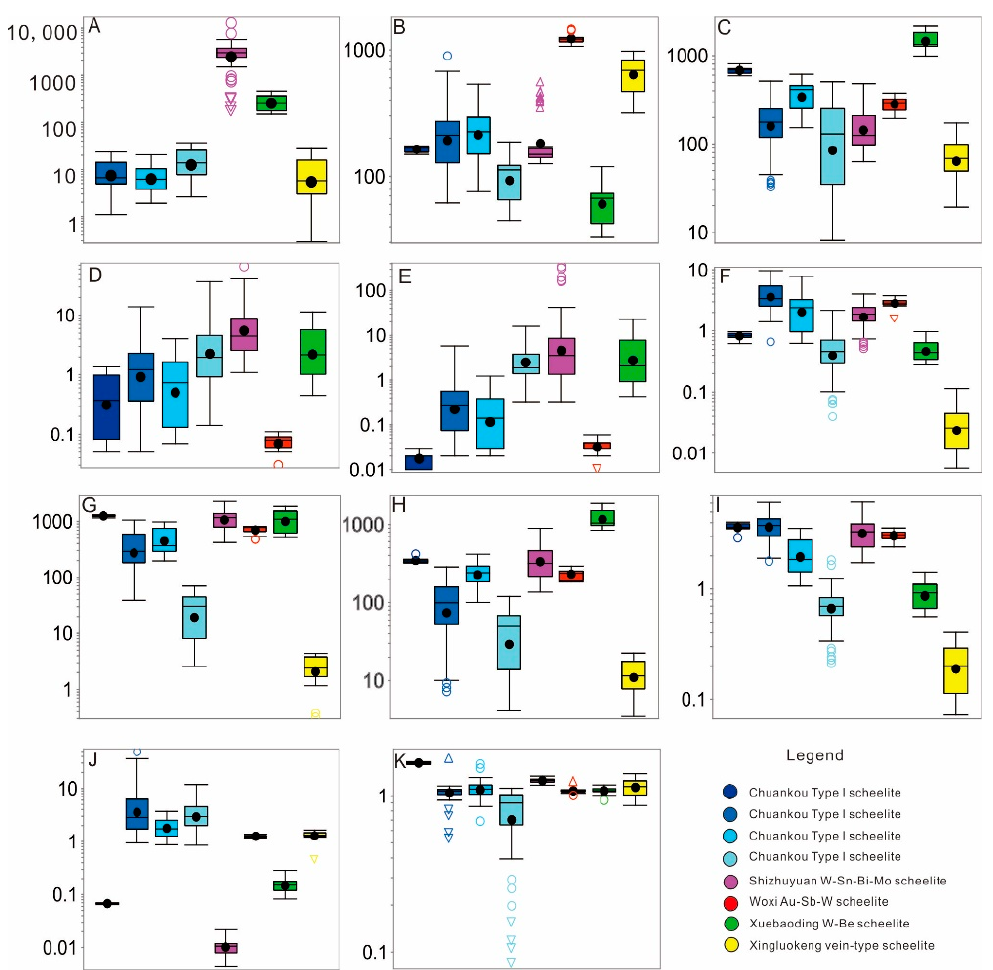
Figure 6. Box plot for trace element ( A ) Mo; ( B ) Sr; ( C ) Y; ( D ) Th; ( E ) U; ( F ) La N / Yb N ; ( G ) LREE; ( H ) HREE; ( I ) LREE / HREE; ( J ) δ Eu; ( K ) δ Ce in Scheelite from the Chuankou deposit and other related